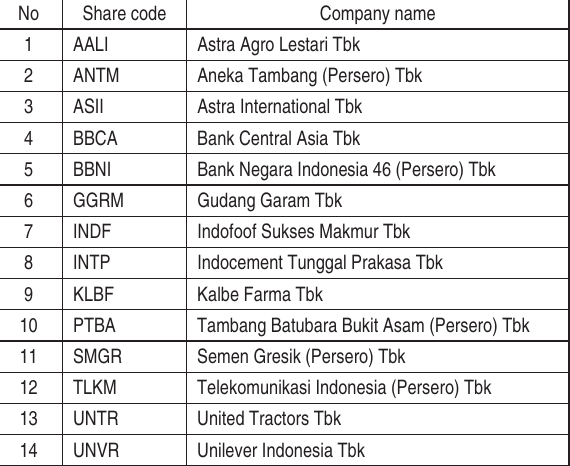
Table 1. Sample of the research